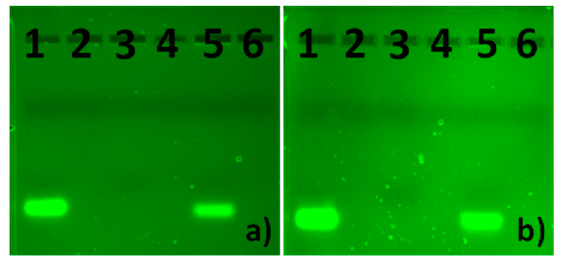
Figure 6. Protective effect of CBD-2 on siRNA in the presence of RNase A/T1 mix. ( a ) CBD-2 + Mcl-1, ( b ) CBD-2 + Bcl-2; 1, naked siRNA; 2, CBD-2; 3, siRNA + RNase; 4, siRNA + CBD-2 + RNase; 5, siRNA + CBD-2 + RNase + heparin; 6, siRNA +